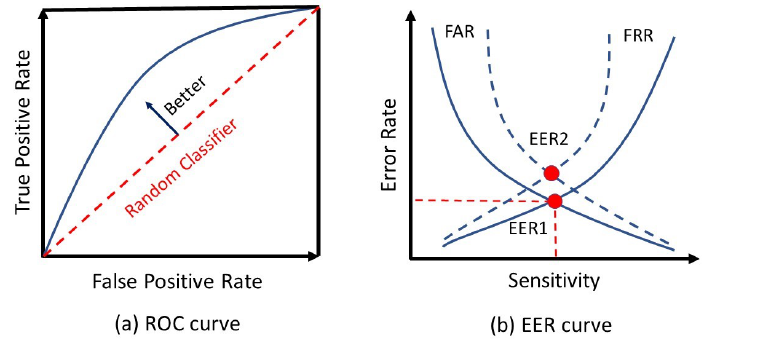
Figure 4. ( a ) ROC curve based on false positive and true positive rate, ( b ) comparing EER for two biometric